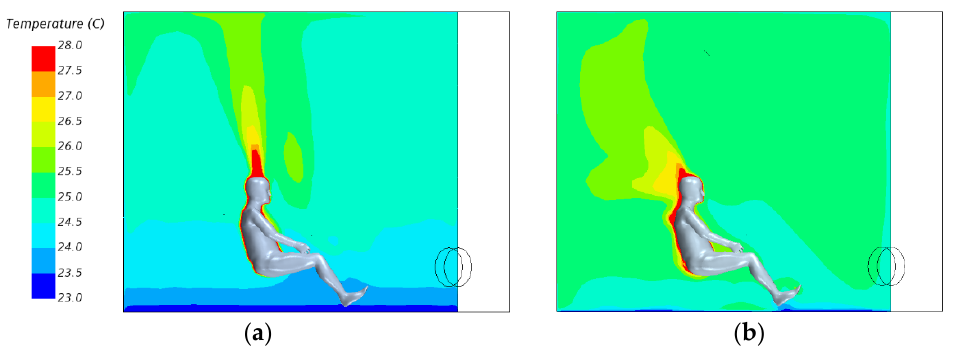
Figure 17. Vertical temperature distribution ( a ) without and ( b ) with a fan.